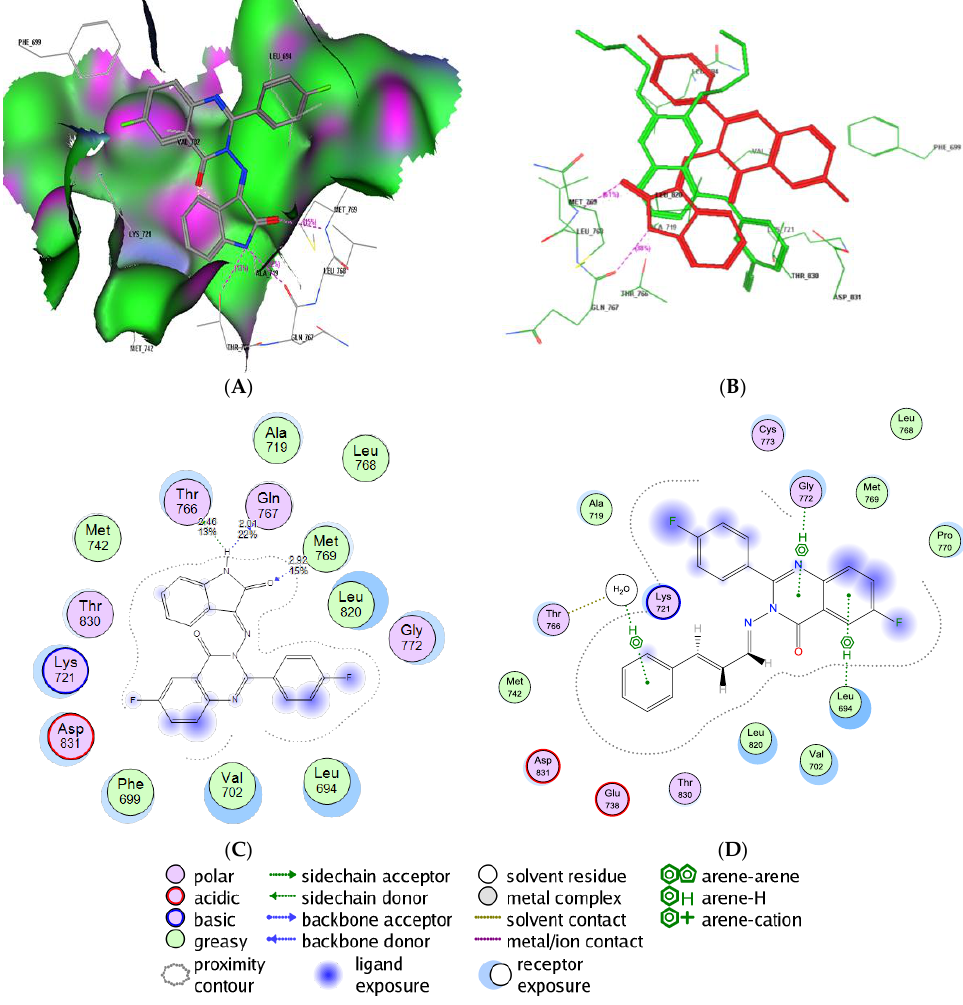
Figure 6. 3D and 2D interactions of compounds 6 and 8 with the EGFR binding site compared to erlotinib reference drug. Image ( A ) shows 3D interactions of compound 6 with EGFR binding site, Image ( B ) shows compound 6 superimposed with erlotinib. Image ( C ) shows 2D interactions of compound 6 with EGFR binding site and image ( D ) shows 2D interactions of compound 8 with EGFR binding site.